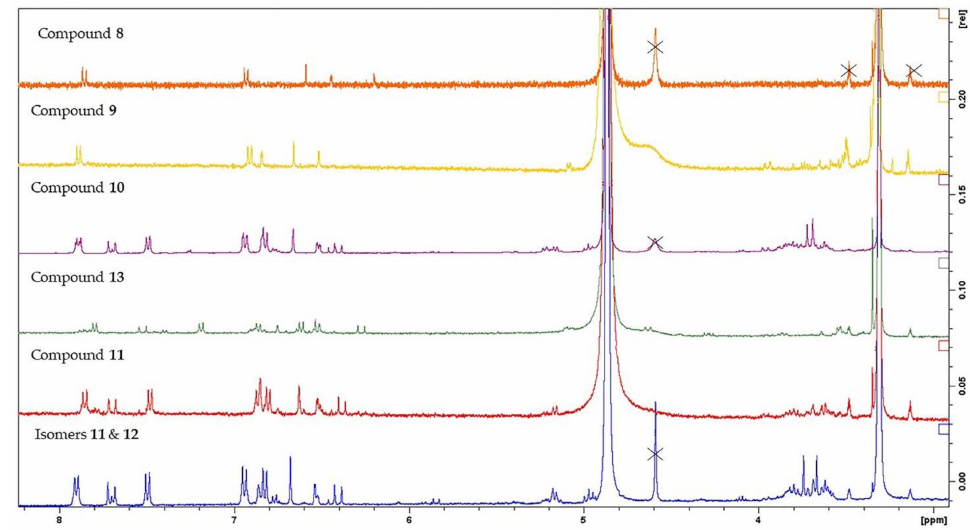
Figure 1. 1 H-NMR spectra of the isolated apigenin derivatives (compounds 8 – 13